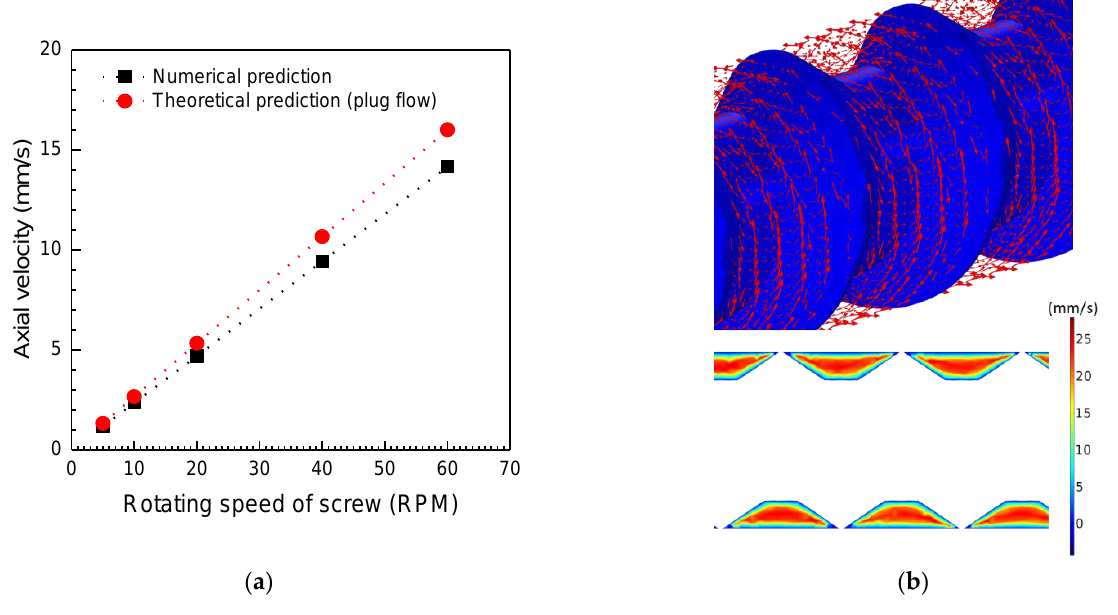
Figure 5. ( a ) Comparison of the average axial velocities of granular graphite flow predicted by numerical simulation and the plug flow analysis. ( b ) Velocity vectors and axial velocity field of graphite flow in the pitch of the screw generated by the rotating screw speed of 60 rpm.